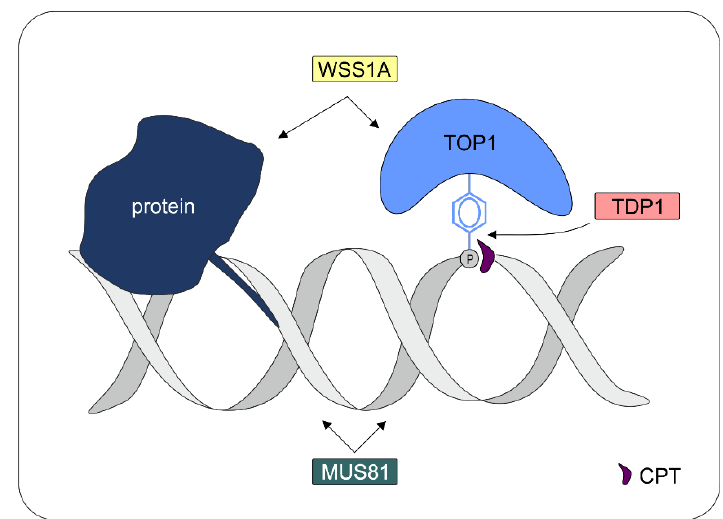
Figure 3. Repair of DPCs in Arabidopsis thaliana . DPCs in general can be repaired via proteolytic degradation by WSS1A and in a parallel pathway via endonucleolytic cleavage by MUS81. Enzymatic DPCs like CPT-induced TOP1ccs can be additionally repaired via hydrolysis of the tyrosyl-phosphodiester bond by TDP1.